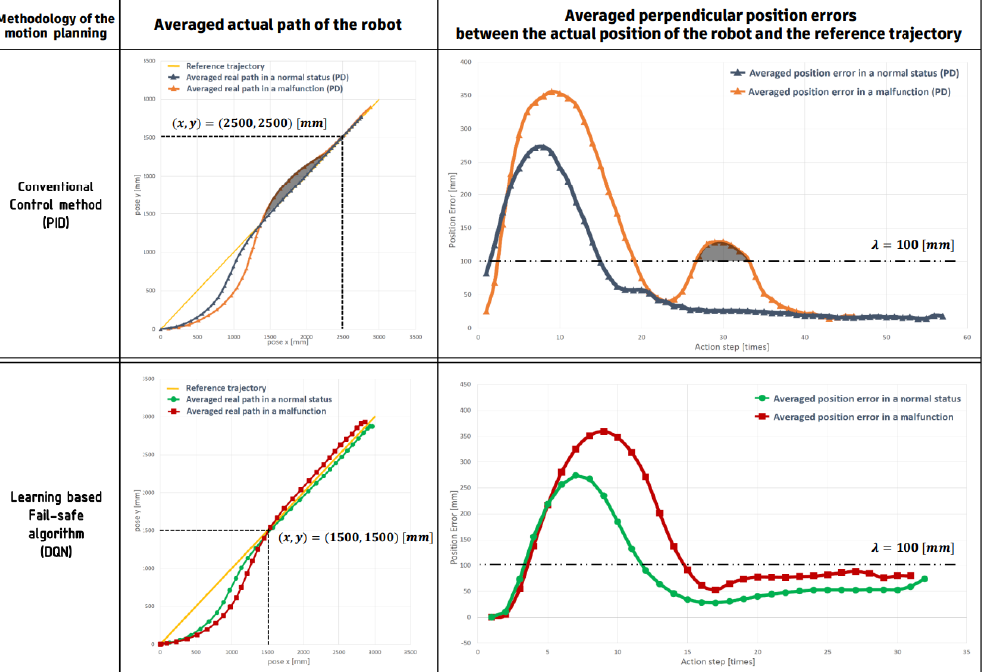
Figure 27. Reliability analysis of the two motion planning methods (PID and DQN), both in a normal state and in the case of a failure in the steering motor.